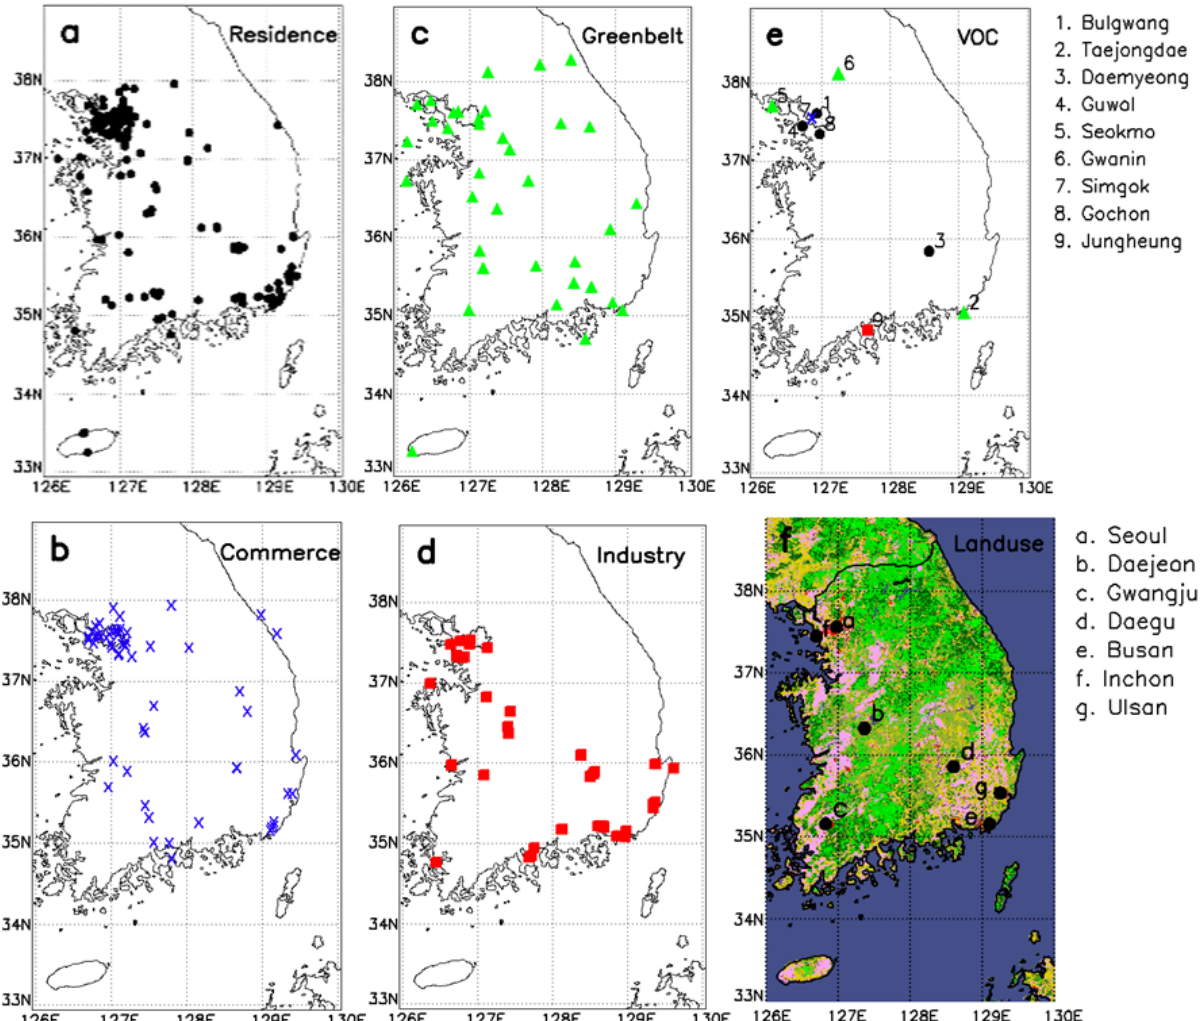
Figure 1. Locations of surface air pollution (O 3 , CO, NO 2 , SO 2 , and PM 10 ) monitoring stations in South Korea during 2002–2013 under the MEK four land-use types of (a) residence (black circle), (b) commerce (blue cross), (c) greenbelt (green triangle) and (d) industry (red square). (e) Locations of the VOC monitoring stations used in this study, under the four land-use types. (f) Locations of seven major cities in South Korea with the satellite-derived AVHRR land-cover types. The VOCs and the five kinds of air pollutants were simultaneously measured at the nine stations in (e) . Please see Table 2 for the observational periods of